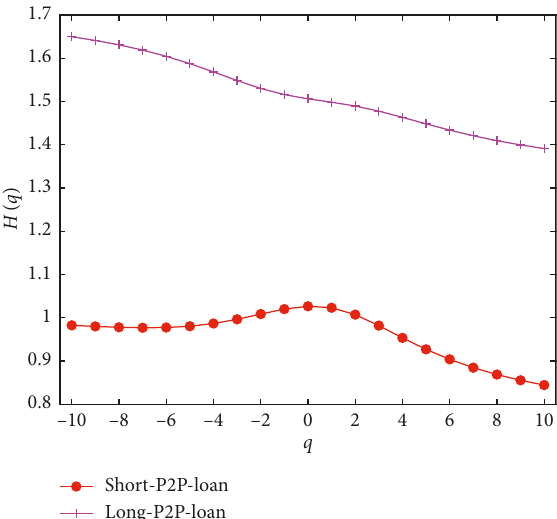
Figure 4: Short and long scaling exponents for P2P lending-offline Table 2: Cross-correlation scaling exponents H with q varying from − 10 to 10.